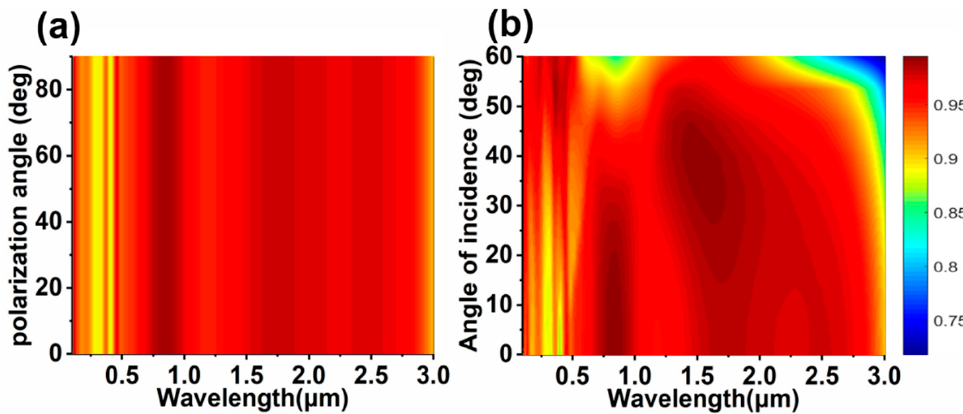
Figure 6. ( a ) The simulated absorption spectra of the designed absorber in TM polarization to TE polarization state and ( b ) the simulated absorption spectrum under the condition of oblique incidence.